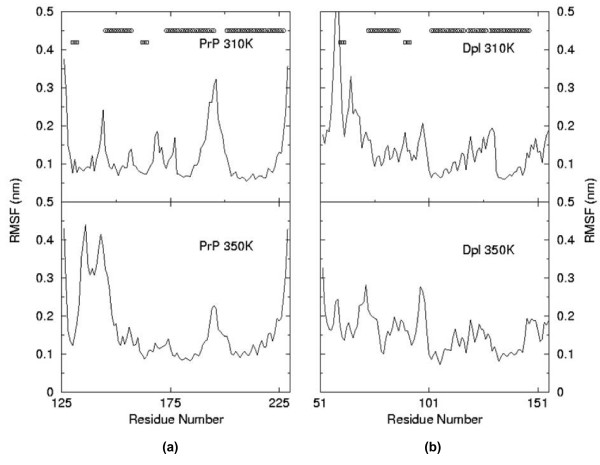
Structural Flexibility of PrP and Dpl. (a) Flexibility of the PrP at 310 K, top panel and at 350 K bottom panel. (b) Flexibility of the Dpl at 310 K, top panel and at 350 K bottom panel.